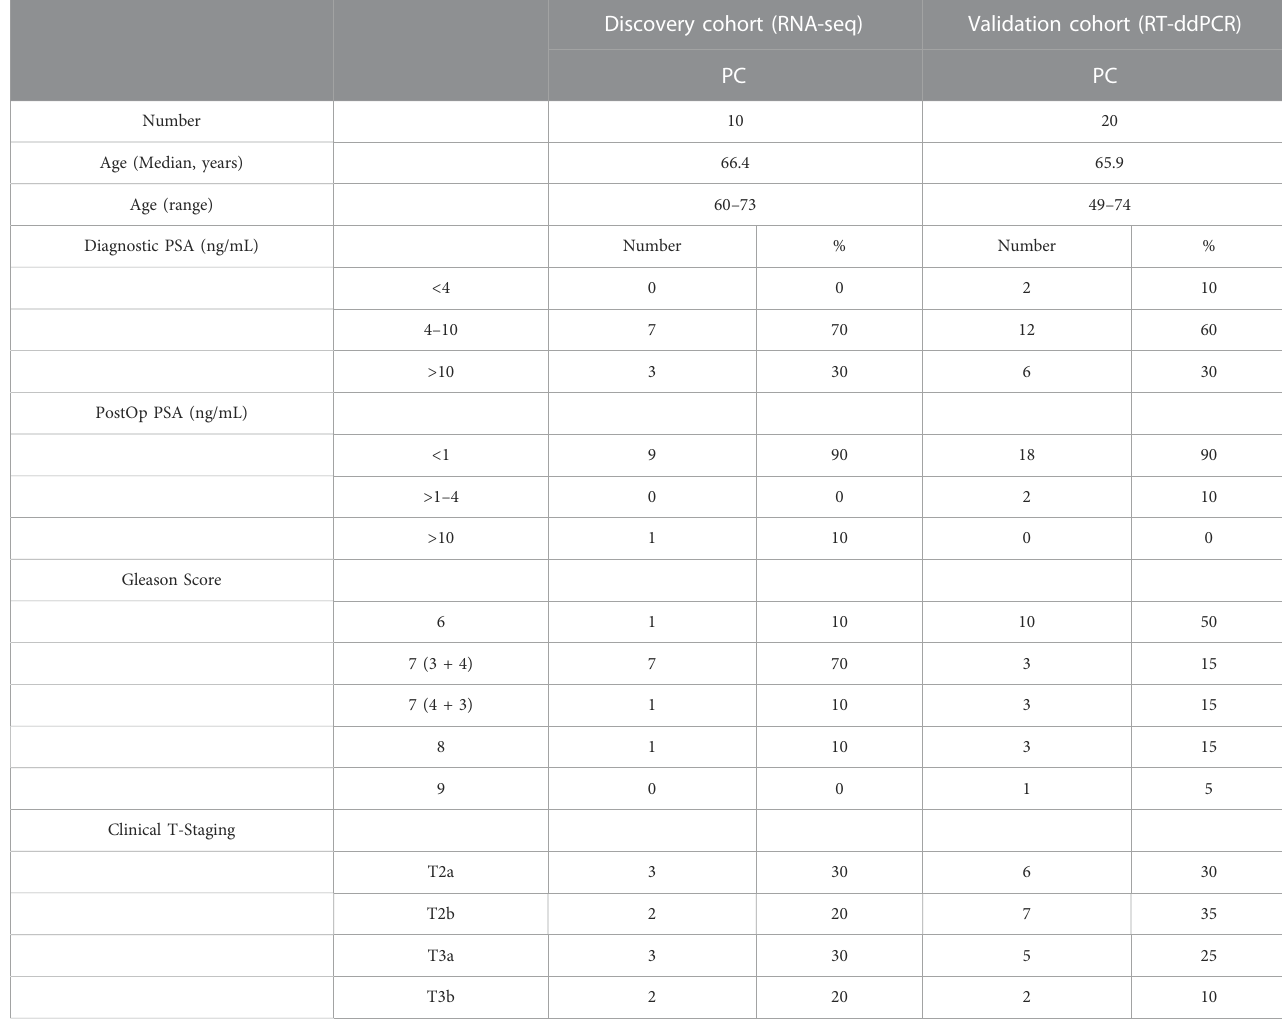
TABLE 1 Patient